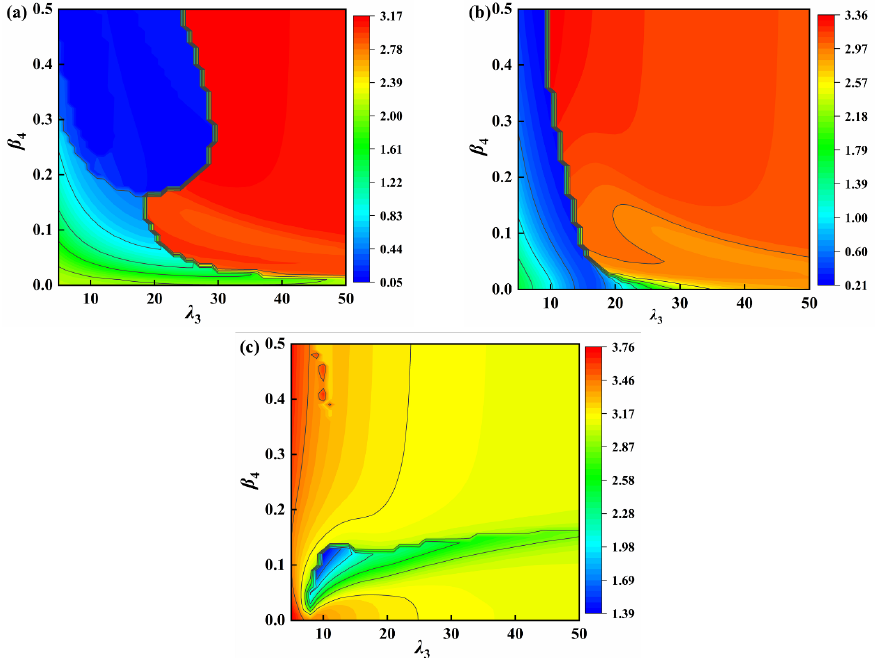
Figure 6. The maximum displacement RMS of the primary structure as the negative stiffness ratio β 4 and the inertance ratio λ 3 under f e = 0.4 mm: ( a ) β 3 = 0.0027; ( b ) β 3 = 0.027; ( c ) β 3 = 0.27.